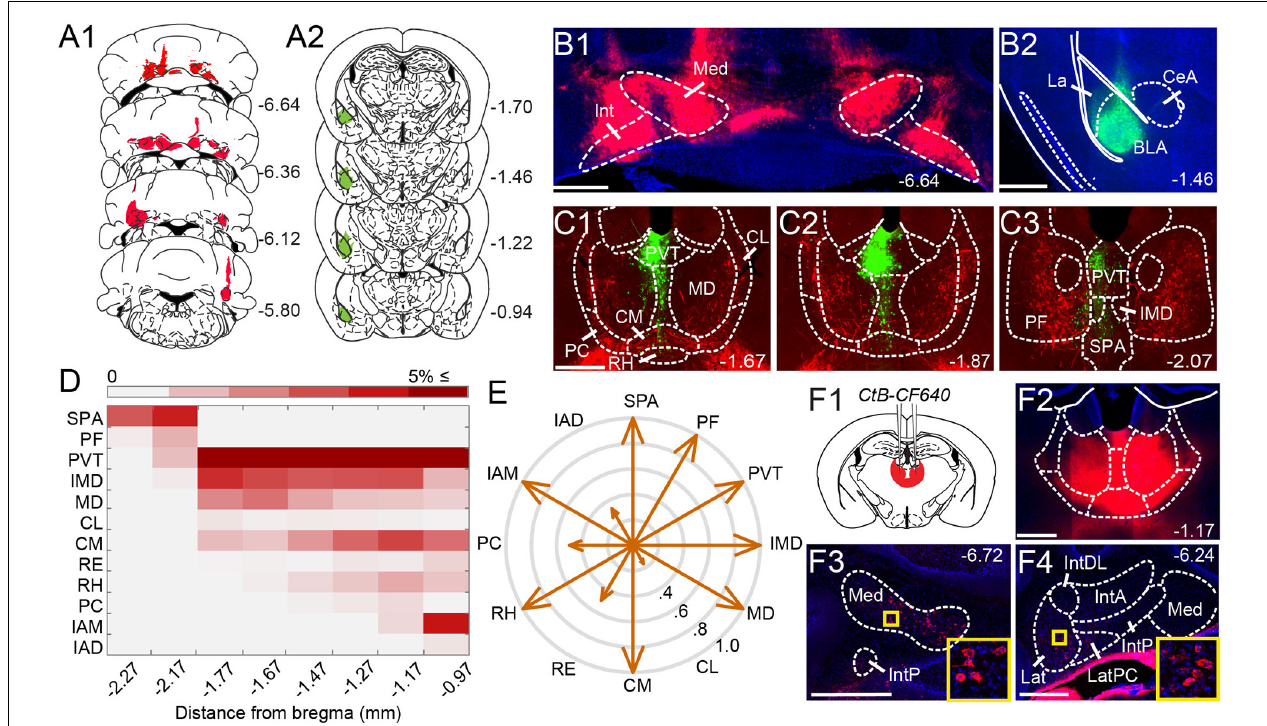
FIGURE 1 | Anatomical tracing uncovers putative disynaptic pathways from the cerebellum to basolateral amygdala. (A) Injection sites for anterograde viral tracer in DCN ( A1 , red ) and retrograde viral tracer in BLA ( A2 , green ). (B) Mosaic epifluorescence image of injection sites in DCN (B1) and BLA (B2) . (C1–C3) Mosaic epifluorescence images of overlapping DCN axons (red) and BLA-projecting neurons (green) in limbic thalamus. (D) Relative distribution of BLA-projecting neurons across nuclei of the limbic thalamus, normalized to the total number of labeled neurons and averaged across experiments, as a function of distance from bregma. Antero-posterior coordinates for each nucleus are given in Table 1 . (E) Quantification of overlap between DCN axons and BLA-projecting thalamic neurons. Arrow length in compass plot indicates proportion (0.0–1.0) of experiments with overlap in each thalamic nucleus. (F1,F2) Schematic and confocal image of injection site for retrograde tracer CtB CF-640 in limbic thalamus. (F3,F4) CtB-labeled projection neurons (red) in DCN at different distances from bregma. Insets show high-magnification images of areas in yellow squares. For all panels, numbers denote distance (in mm) from bregma. Blue: DAPI. Scale bars: 500 µ m.